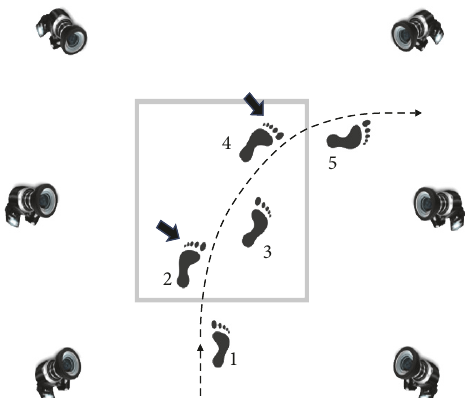
Figure 2: Schematic representation of the experimental set-up. The squaredenotestheareawheretheindividualstookturn;turningpart of the task is shown with two arrows indicating the moment of the toe-off during the second step and the toe-off during the fourth step. Step numbers are